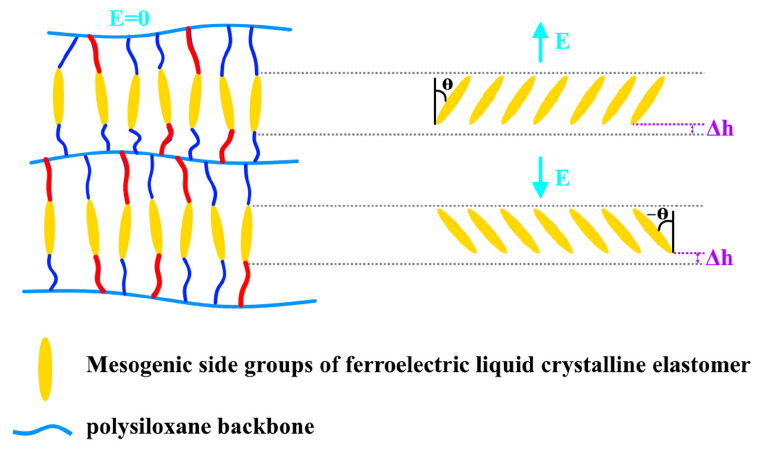
Figure 11. The electroclinic effect in ferroelectric liquid crystalline elastomers. The polarized meso- genic side groups will turn by “ θ ” or “ − θ ” depending on the direction of the electric current flow E (electric field out of or into the plane of material). Δ h—a decrease in the thickness of the polarized mesogenic side groups during the application of the electric field. Liquid crystal elastomers produce high stress and strain by increasing the tempera ‐ ture, and they need lower electrical voltage 100 times compared to dielectric and ferroe ‐